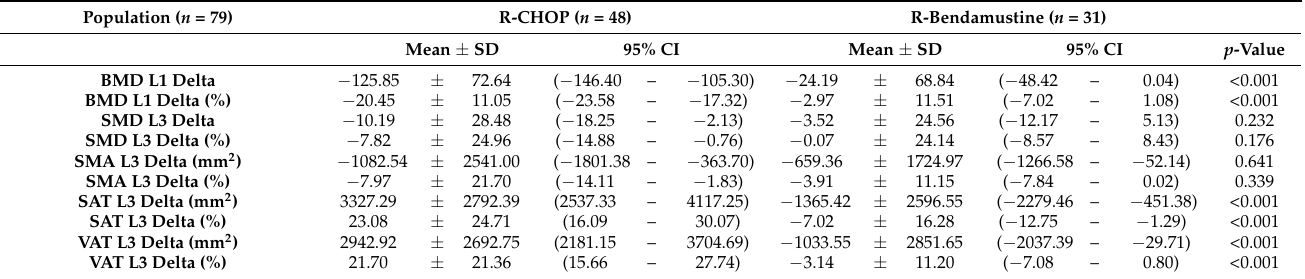
Table 3. Descriptive characteristics stratified by R-CHOP vs. R-Bendamustine therapy: Radiomics data-delta.